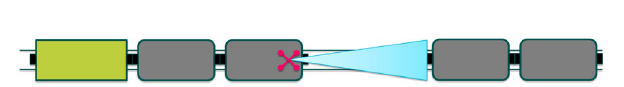
Fig. 6. Detecting an object on the rails and finding the distance till the object.